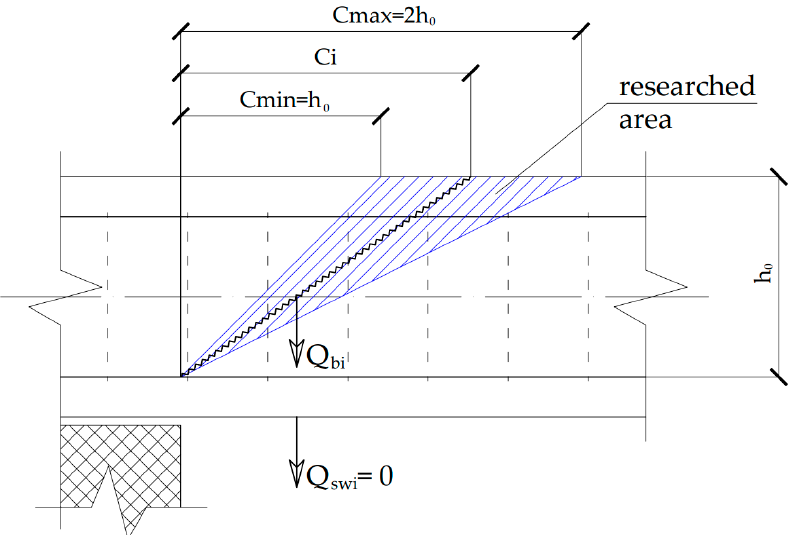
Figure 3. Limits of application of the design scheme, where: Q b is the force perceived by concrete, Q sw is the force perceived by transverse reinforcement, h 0 is the working height of the cross-section, C is the distance from the support to the upper edge of the studied inclined section.